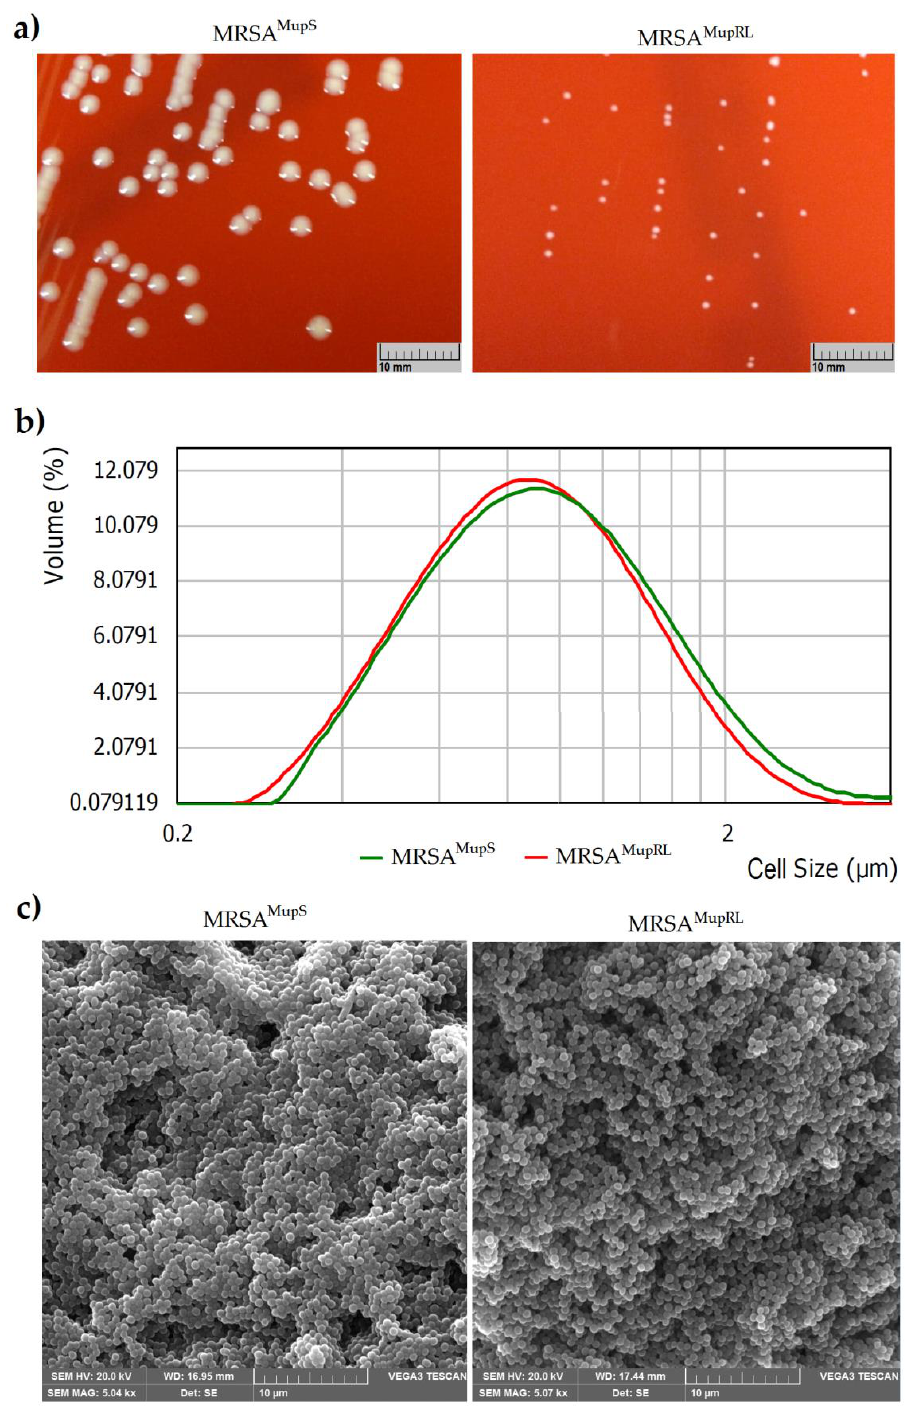
Figure 1. Comparison of the sizes of growing MRSA MupS and MRSA MupRL colonies on Columbia agar with 5% sheep blood ( a ), and cells using Mastersizer 2000 ( b ), and SEM ( c ).